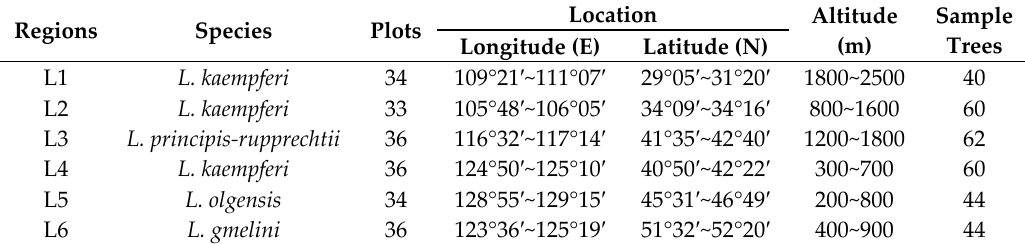
Table 1. Six larch plantation study